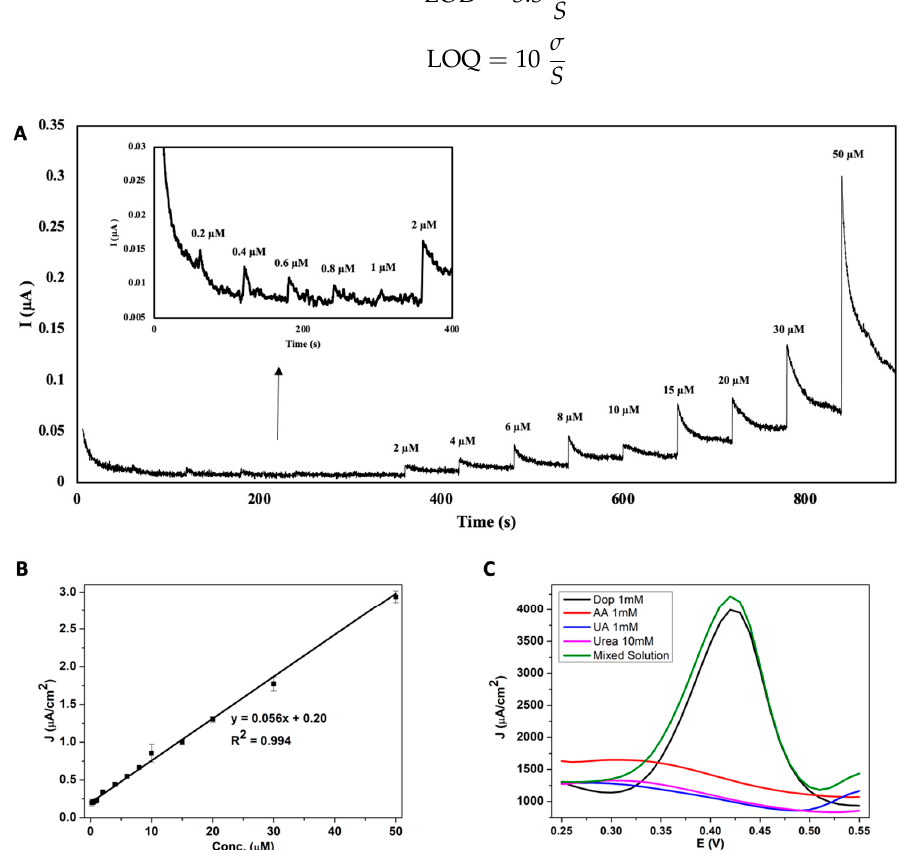
Figure 10. ( A ) CPA results for dopamine concentration ranging from 0.2 µM to 50 µM in 0.1 HCl solution at a constant potential of 0.45 V. ( B ) the calibration curve of AuNS-modified SPCE towards dopamine. ( C ) DPV measurements for selectivity test of 1 mM dopamine, 1 mM AA, 1 mM UA, 10 mM urea, and the mix of the mentioned solution.